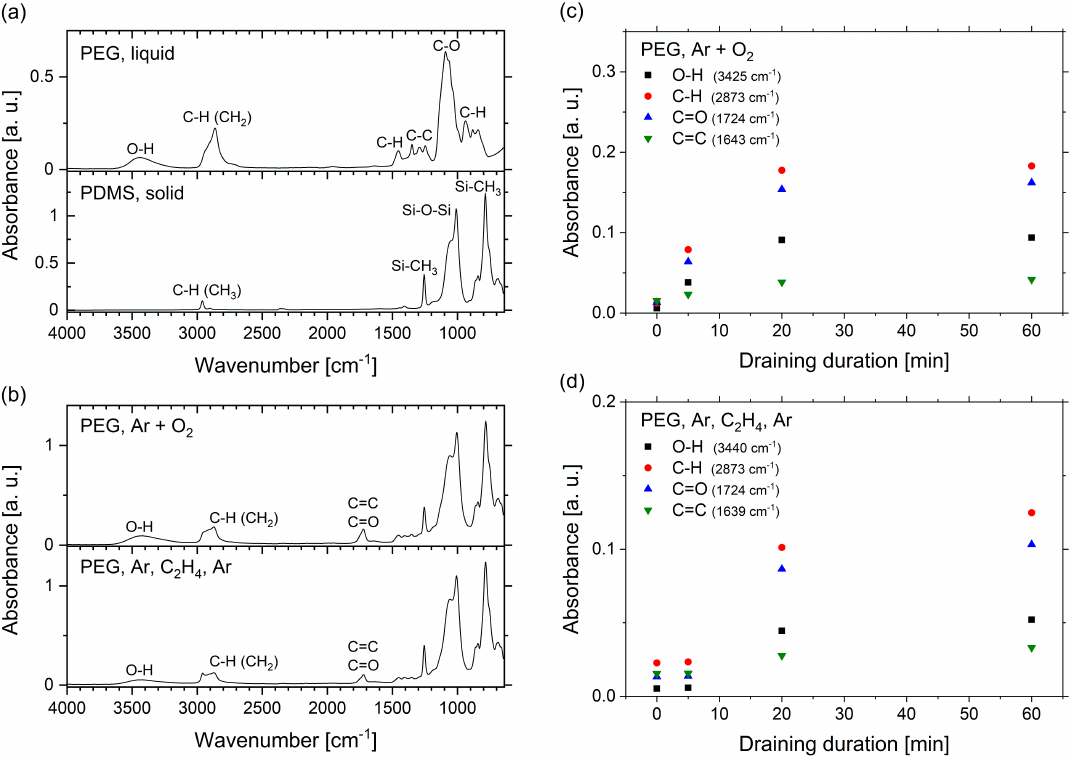
Figure 6. ( a ) FTIR spectra of liquid PEG and cured PDMS. ( b ) FTIR spectra of plasma-treated PEG samples. ( c ) Peak intensity of the Ar-O 2 samples depending on the draining duration. ( d ) Peak intensity of the Ar-C 2 H 4 -Ar samples depending on the draining